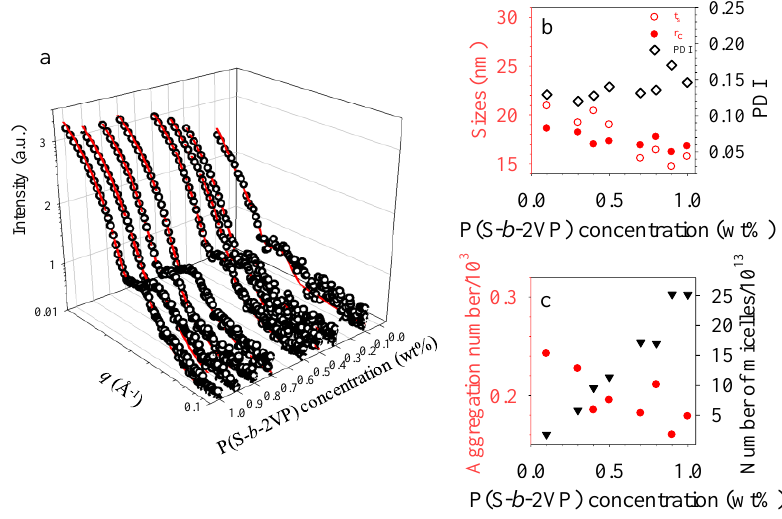
Figure 5. ( a ) Experimental small-angle X-ray scattering (SAXS) data (symbols) and fitted curves (lines) for P(S- b -2VP) core-shell micelles at varied mass fractions in toluene; ( b ) Mean radius of P2VP cores ( r s , red filled circles), thickness of PS shells ( t s , red open circles) and polydispersity of the P2VP cores (PDI, black open diamonds); and ( c ) aggregation number (red filled diamonds) and number of micelles (black filled triangles) as deduced from the fits are plotted as a function of P(S- b -2VP) concentration. The structural parameters that were extracted from the fits are summaried in Figure